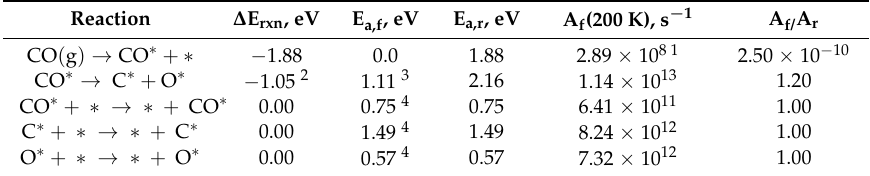
Table 3. Reaction energies, energy barriers and pre-exponential factors at 200 K in the absence of lateral interaction for the reaction steps in CO-TPD.